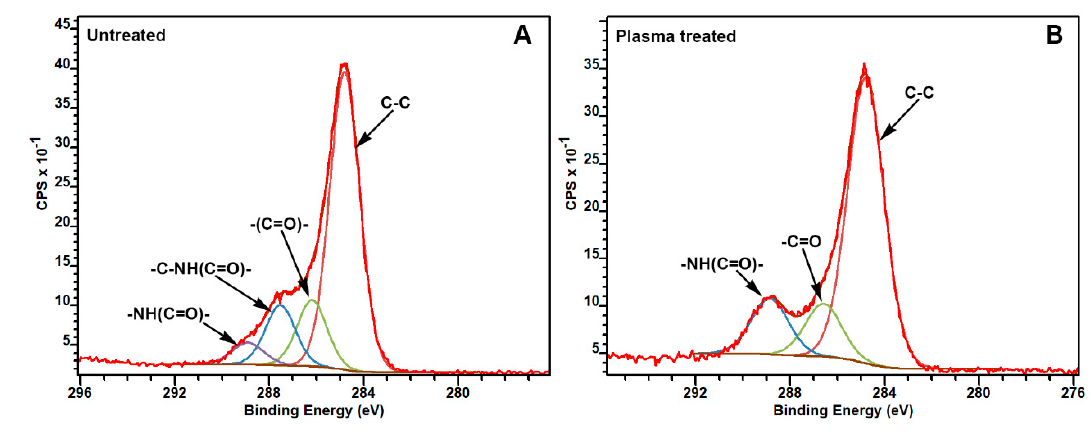
Figure 4. High-resolution XPS spectra of the C1s binding energy region of polyamide fabrics before ( A ) and after plasma treatment ( B ). The positions of different functional groups are indicated. Table 2. XPS results of plasma-untreated and treated samples.